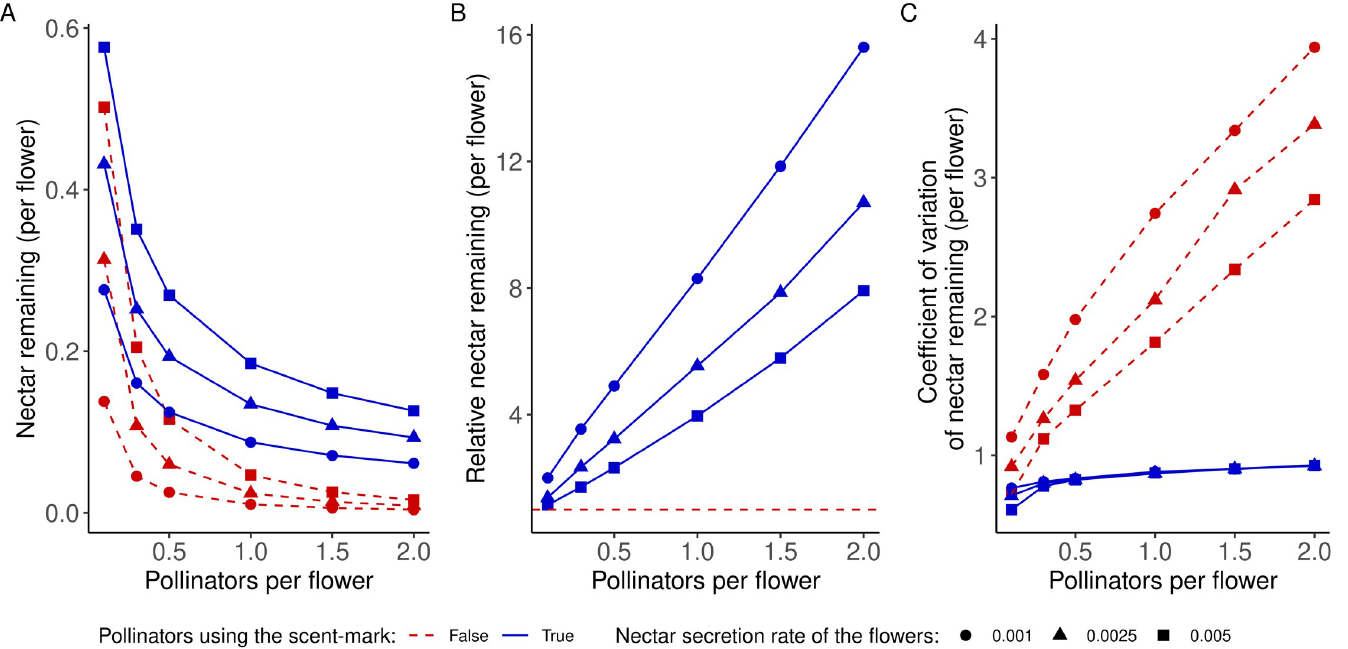
Fig 5. (A) Mean amount of nectar remaining in the flowers at the end of the simulation. (B) Ratio of the amount of nectar remaining in the flowers when pollinators do and do not use the scent mark. The red dashed line represents the threshold where the nectar quantity remaining is equal for both strategies. (C) Coefficient of variation of the nectar remaining in the flowers at the end of simulation. In each figure, the x-axis represents the relative abundance of pollinators compared to flowers.